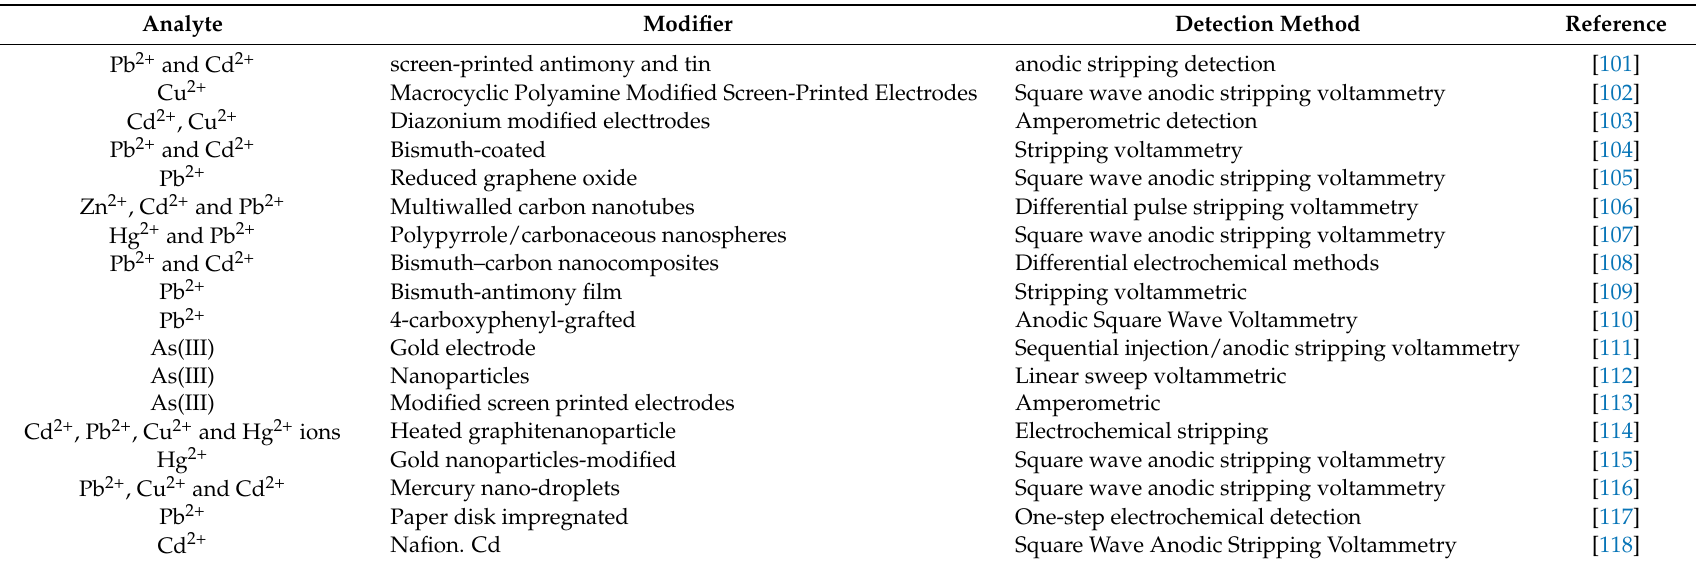
Table 5. Selected and recently developed screen-printed sensors for heavy metal